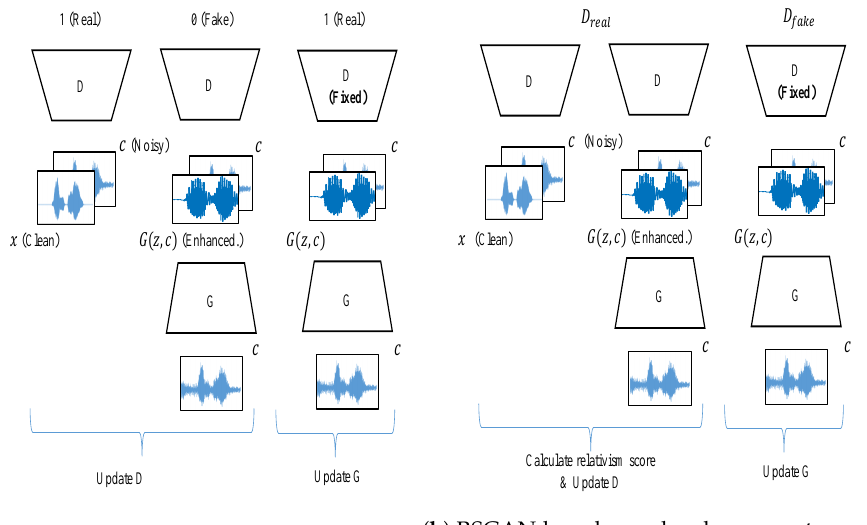
Figure 1. Illustration of the conventional GAN-based speech enhancements. In the training of cGAN-based speech enhancement, the updates for generator and discriminator are alternated over several epochs. During the update of the discriminator, the target of discriminator is 0 for the clean speech and 1 for the enhanced speech. For the update of the generator, the target of discriminator is 1 with freezing discriminator parameters. In contrast, the RSGAN-based speech enhancement trains the discriminator to measure a relativism score of the real sample D real and generator to increase that of the fake sample D fake with fixed discriminator